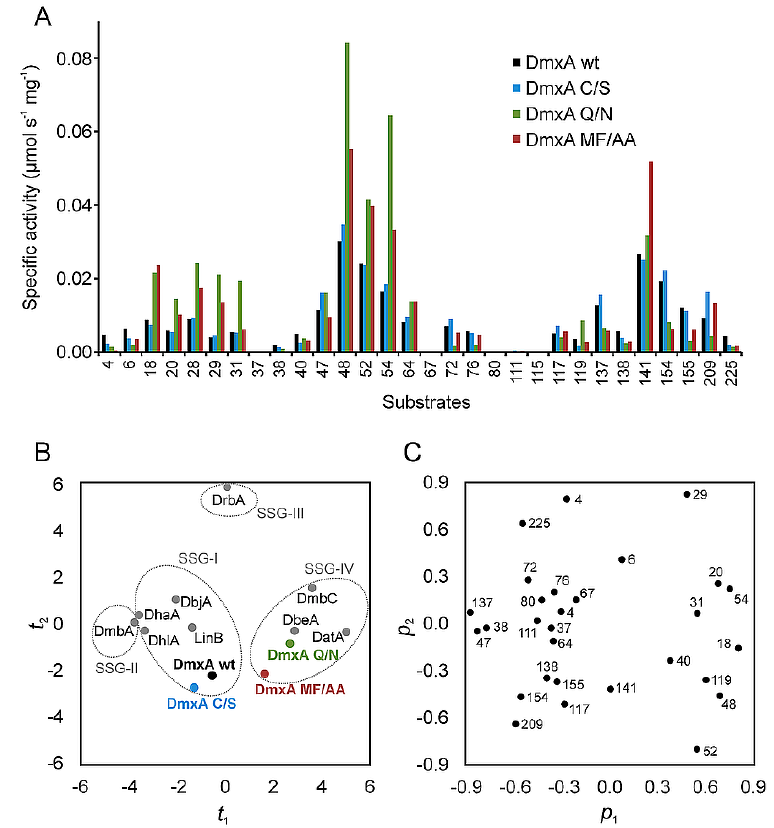
Figure 2. Substrate specificity of DmxA wt and its variants. ( A ) The substrate specificity profiles determined with thirty halogenated substrates. DmxA wt exhibits activity toward 26 out of 30 substrates. ( B ) The score plot t 1 / t 2 from principal component analysis with a transformed dataset. The score plot is a two-dimensional window into the multidimensional space, where the objects (enzymes) with similar properties (specificity profiles) are collocated. The t 1 / t 2 score plot describing 44% of variance in the dataset shows clustering of HLDs into individual substrate specificity groups (SSGs). Unlike DmxA wt and DmxA C / S, both belonging to SSG-I, DmxA Q / N and DmxA MF / AA were clustered into SSG-IV together with DbeA, DatA and DmbC. ( C ) The corresponding loading plot p 1 / p 2 from the principal component analysis showing the substrates that govern the clustering of enzymes into individual SSGs. Variables localized further from the origin contribute to the principal component more than the variables localized closer to the origin of the plot. The numbering of the substrates is provided in Table S1.